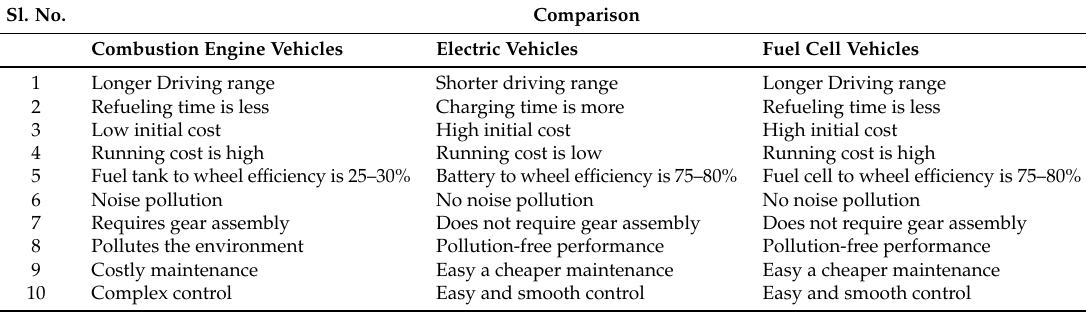
Table 2. Comparison of combustion engine vehicles and electric vehicles. Sl.